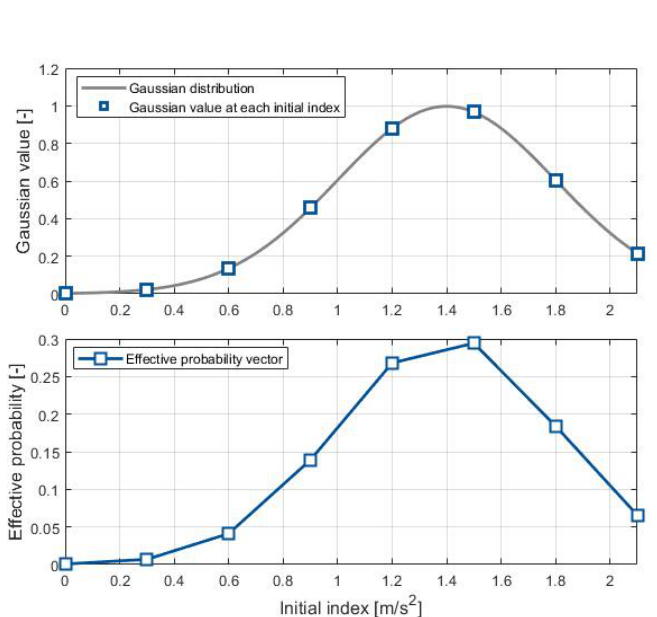
Figure 10. Gaussian distribution using value of initial index.